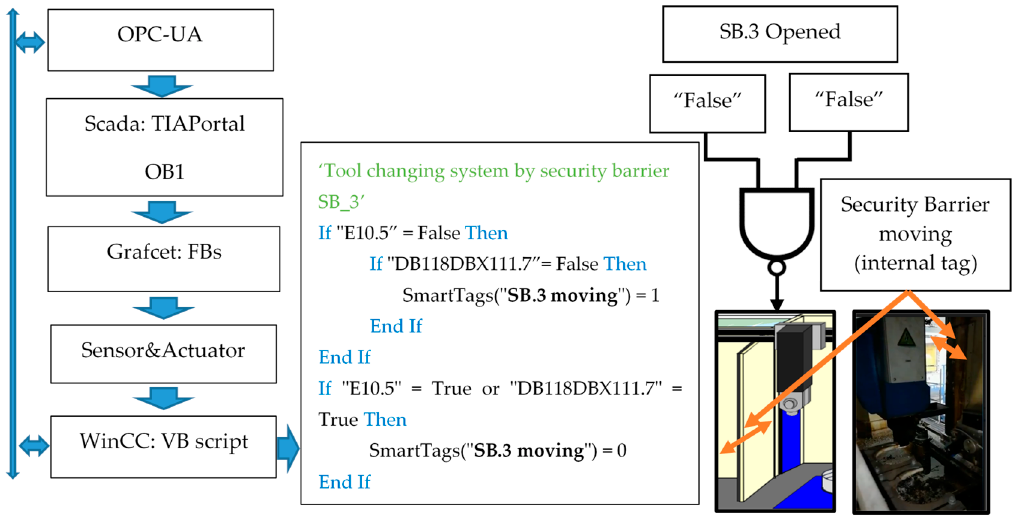
Figure 4. Extract of the VBScript encoded to control an internal security barrier of a machine.